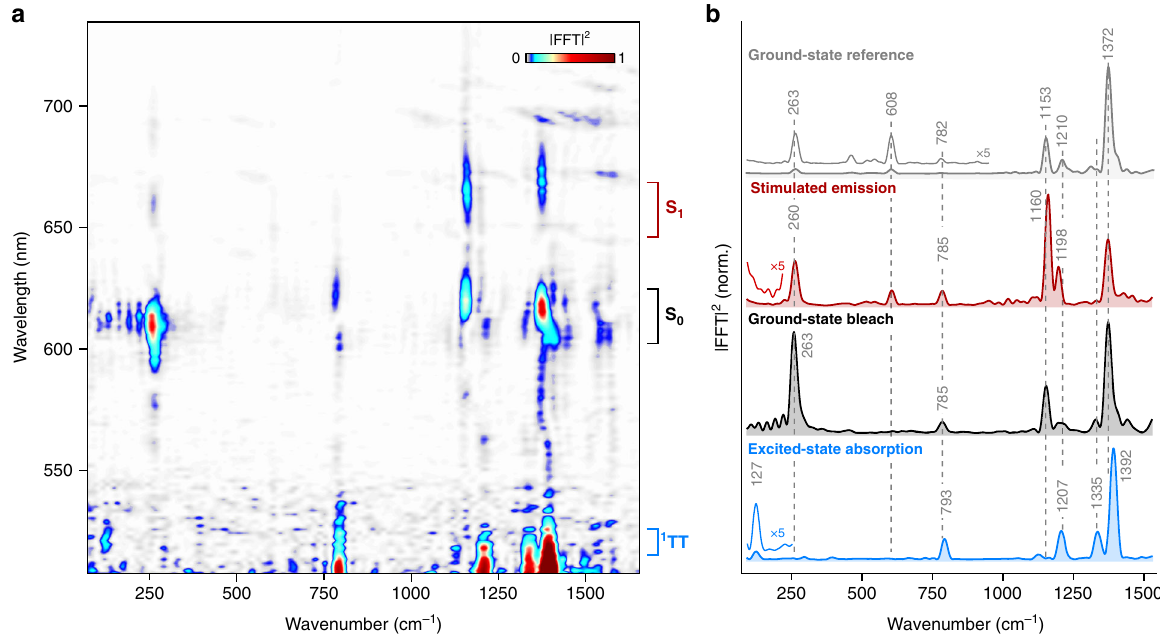
Fig. 2 Impulsive vibrational spectroscopy of DP-Mes. a Wavelength-resolved impulsive Raman map of DP-Mes thin fi lm following impulsive photoexcitation into S 1 . FFT: fast Fourier transform. b Impulsive Raman spectra for different spectral components, integrated as shown by brackets in ( a ): stimulated emission — 645 – 665nm (red, S — 605 – 625nm (black, S — 515 – 525 nm (blue, 1 TT). The off-resonant impulsive 1 ), ground-state bleach 0 ), excited-state absorption Raman spectrum of DP-Mes in S 0 averaged over probe wavelengths from 605 to 625nm is shown for comparison (grey, details in Methods). Dashed vertical lines highlight the difference between ground-state vibrational modes and those identi fi ed in 1 TT. All spectra are normalised to the strongest peak